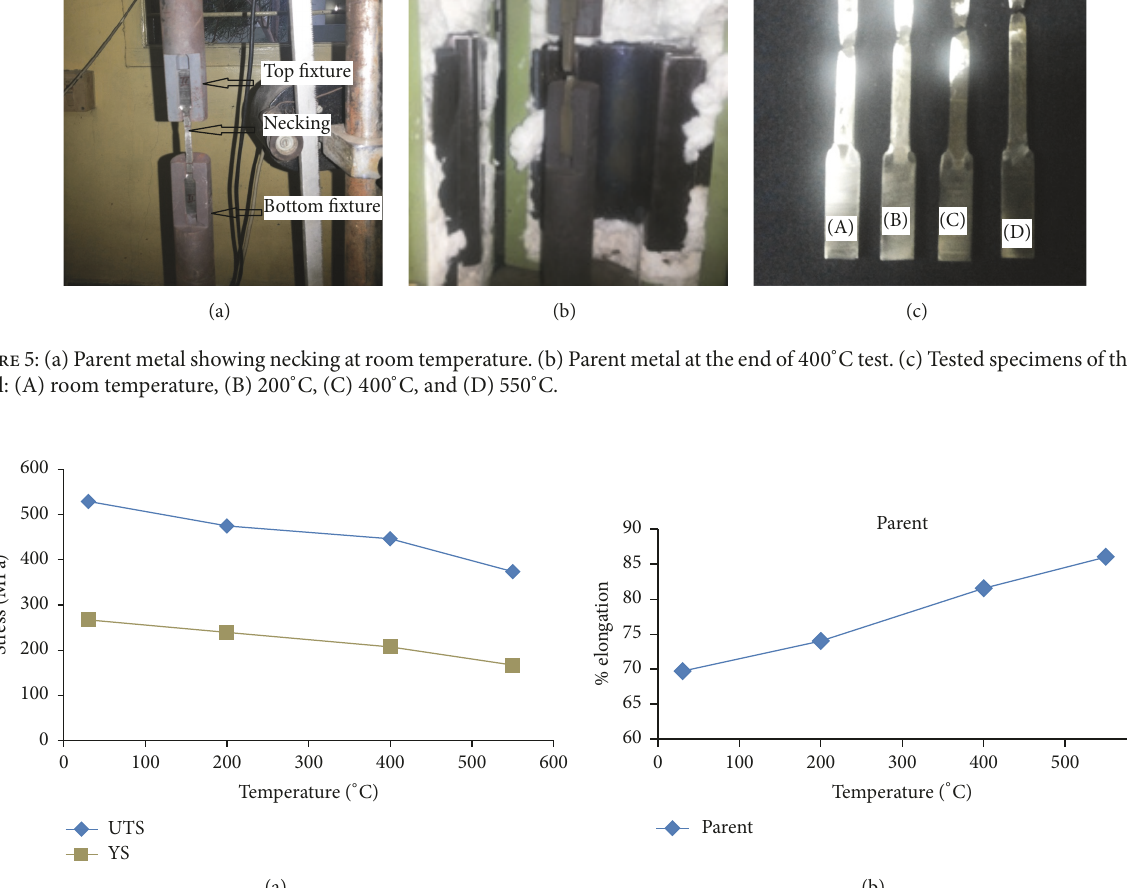
to the precipitation of alloy carbide at the grain boundaries of austenite because the formation of carbide precipitation starts at 425 ∘ C (ASME volume 9) for austenitic stainless steel. As the temperature increases, the strain corresponding to UTS decreases from 90% at room temperature to 40% at the peak operating